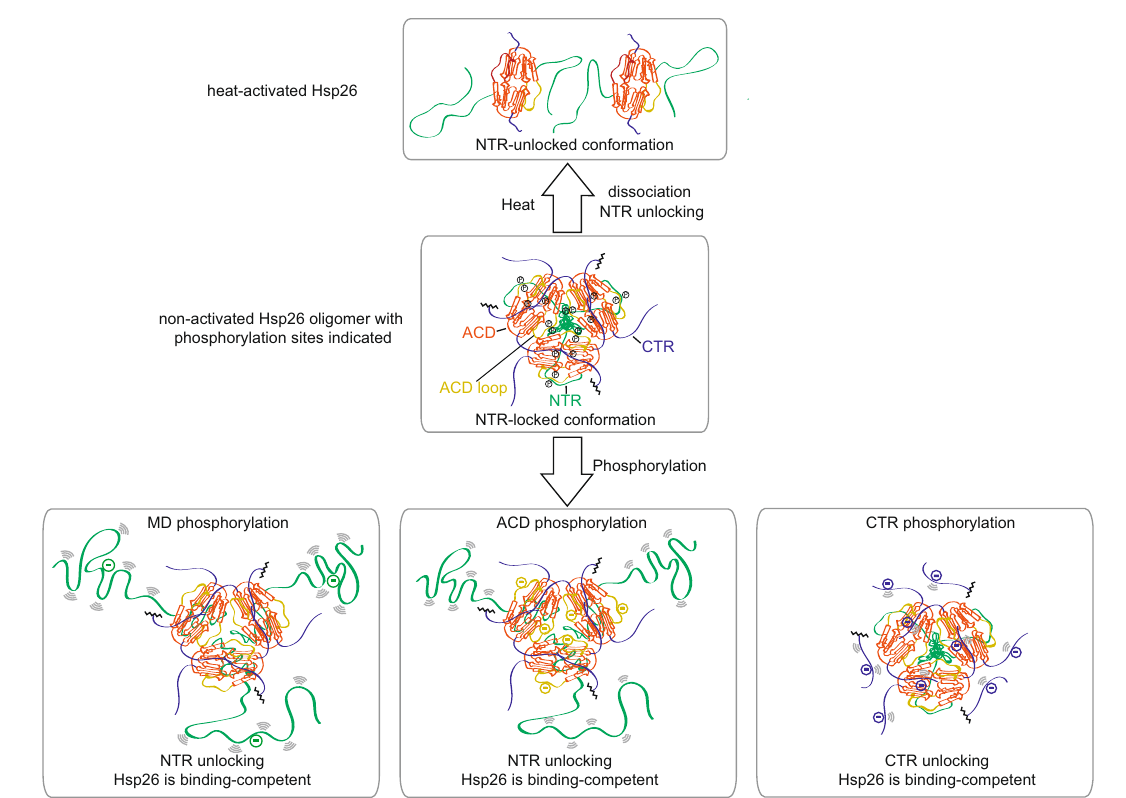
Fig. 6 Activation of Hsp26 by phosphorylation-induced unlocking of the MD. In the inactive state, the MD (dark green) interacts with a big loop of the ACD (orange-red). Therefore, it is buried in the oligomer and not able to bind substrate proteins. The MD can be liberated by increasing temperature, which goes along with the dissociation of the oligomer. Alternatively, phosphorylation in speci fi c parts of the MD, ACD, and CTR (blue) can also lead to the unlocking of the NTR. The circle segments represent the dynamics of the NTR or